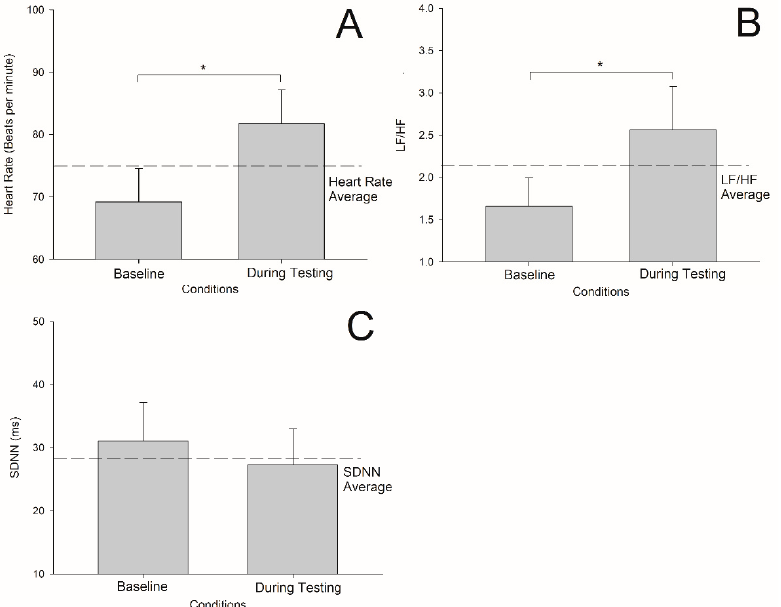
Figure 1. HR, LF/HF, and SDNN comparison analyses between two conditions (baseline and during testing) were conducted. ( A ) HR during testing was higher than baseline HR ( p = 0.01). ( B ) LF/HF during testing was higher than baseline LF/HF ( p = 0.03) ( C ) SDNN during testing was not significantly lower than baseline SDNN. ( p = 0.8). * p < 0.05.